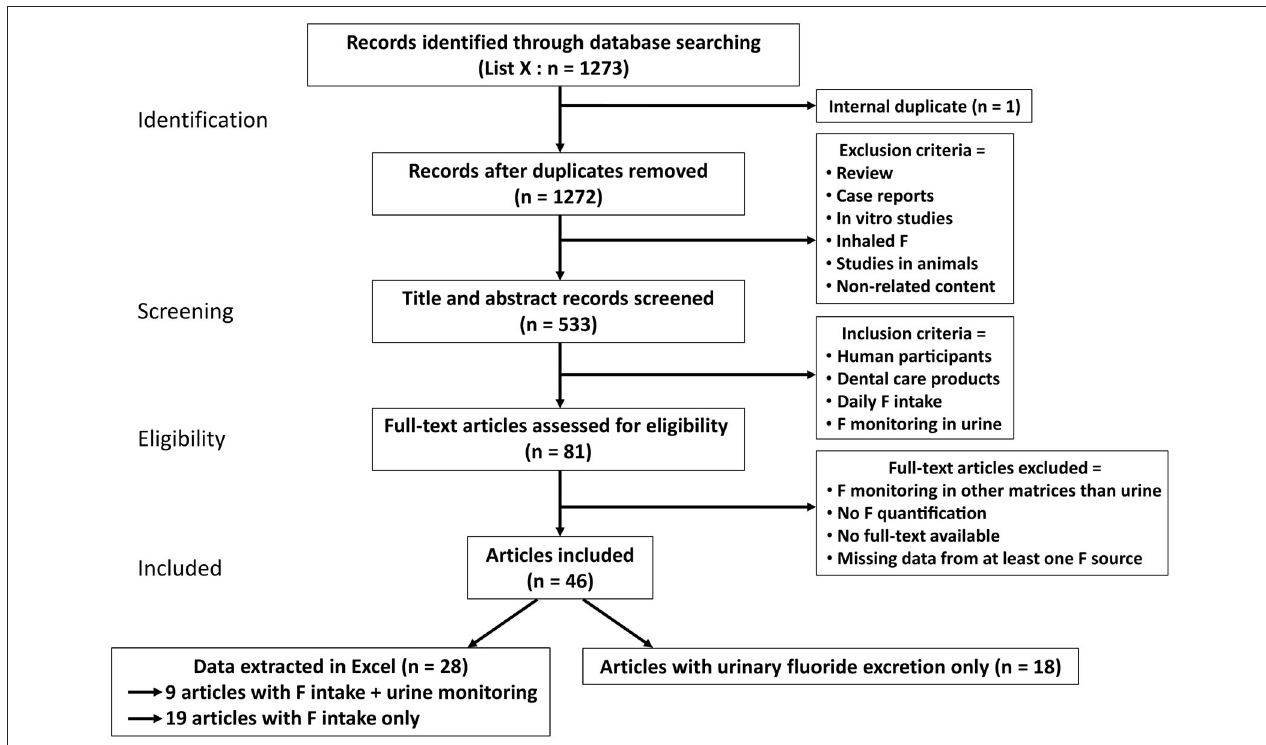
FIGURE 1 | The Preferred Reporting Items for Systematic Reviews and Meta-Analyses (PRISMA) flowchart for the systematic review. From the 1,273 articles found in PubMed included in the search, 46 studies were included and 28 selected in this review for their analyses. Among the 28 articles, 19 only listed the estimated total daily fluoride intake (TDFI) ( Table 1 ). The other nine articles had information regarding both the TDFI and the daily urinary fluoride excretion (DUFE) ( Table 2